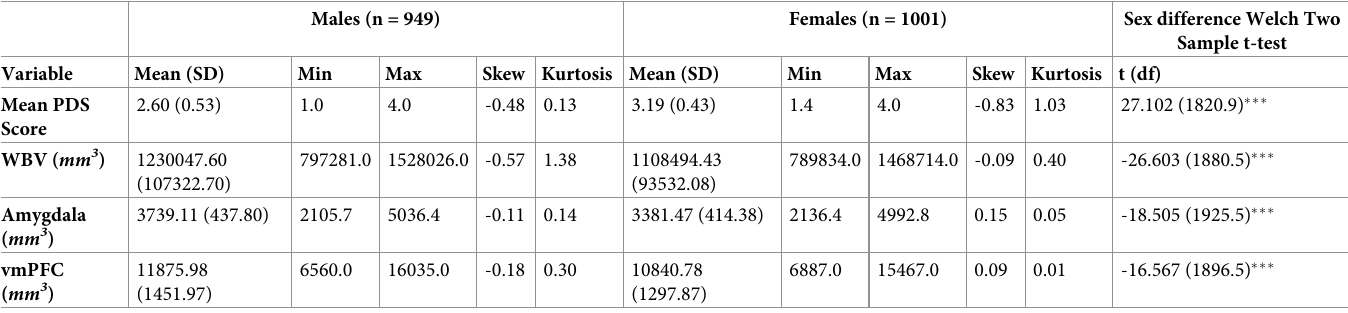
Table 2. Descriptive statistics for the continuous variables in the sample with complete data, separately for males and females (N = 1950). Males (n = 949) Females (n = 1001) Sex difference Welch Two